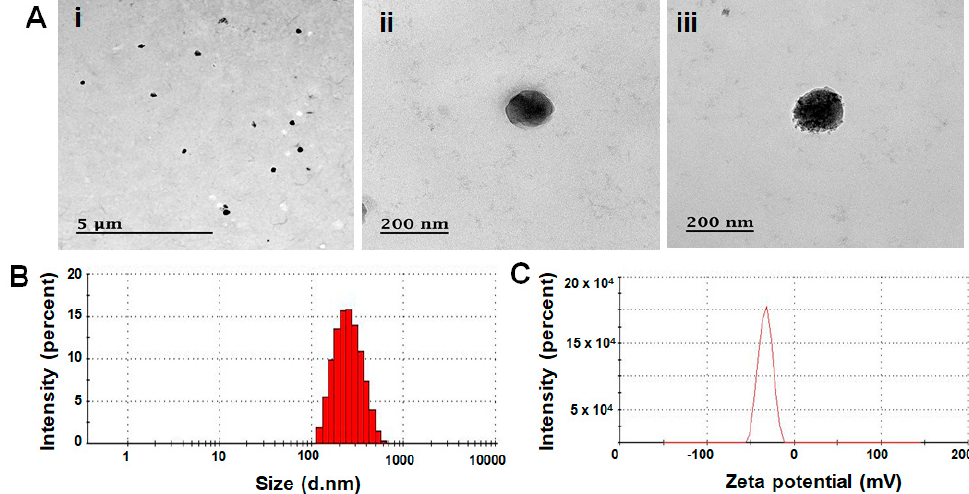
Figure 3. FE-TEM images of PPG-cRGD NPs ( A i,ii) and PPG-cRGD-IR-780 NPs ( A iii). ( B ) Hydrodynamic size of PPG-cRGD NPs analyzed by dynamic light scattering. ( C ) Zeta potential of PPG-cRGD NPs measured by Zeta sizer.